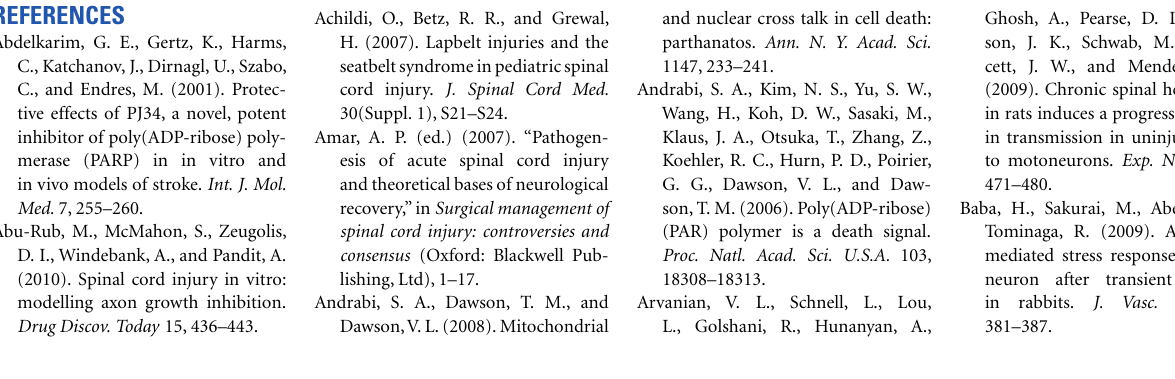
spinal gray matter area containing a fixed region of interest ( Figure 5C ; 350 × 350 μ m) for immunochemical determination of neuronal numbers. Thus, on one side of a 30 μ m section, there are, on average, approximately 315 NeuN-positive neurons.